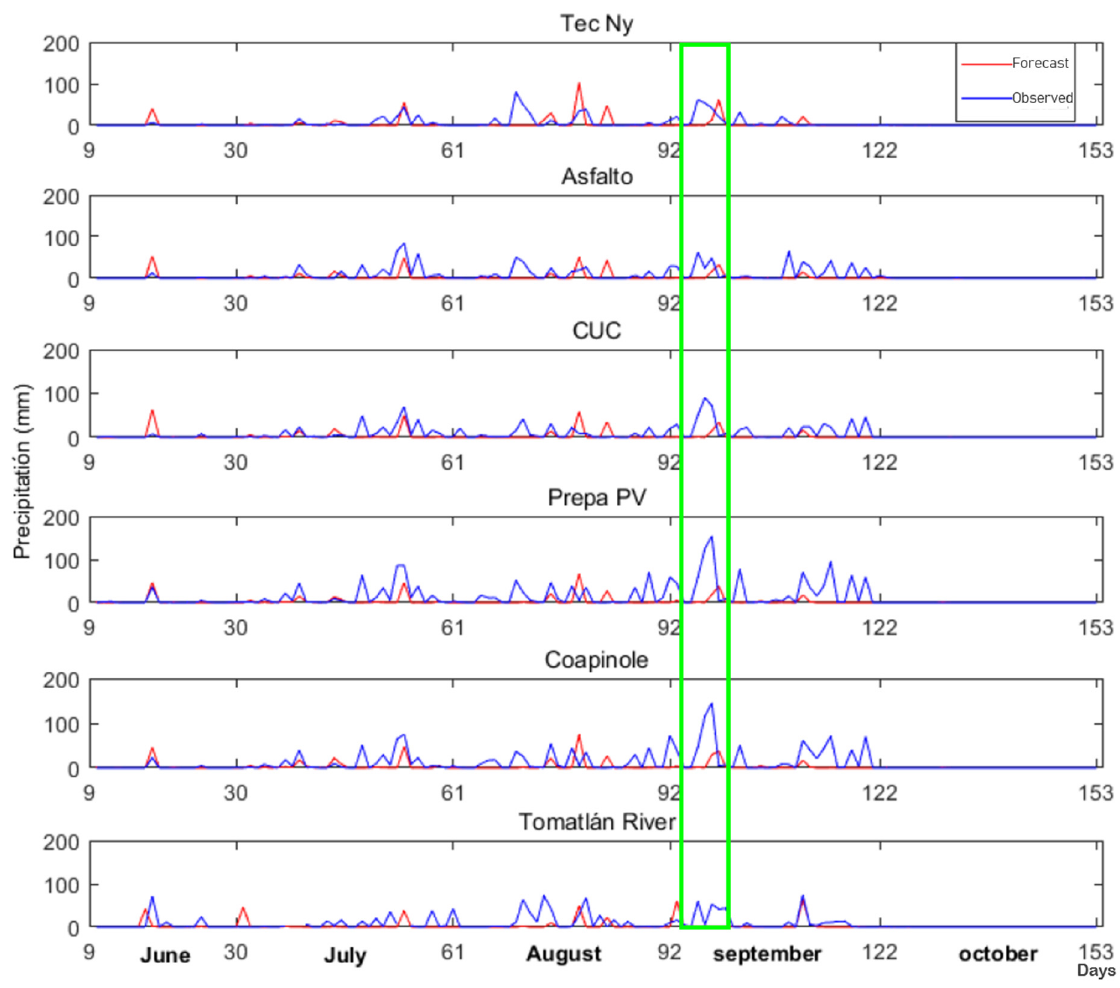
Figure 5. Forecasted (red) and observed (blue) precipitation time series for each of the meteorological stations, per day, from 00:00 h UTC on June 10th to 24:00 h UTC on 31 October 2010. The green rectangle corresponds to an event that occurred between 4 and 6 September 2010.